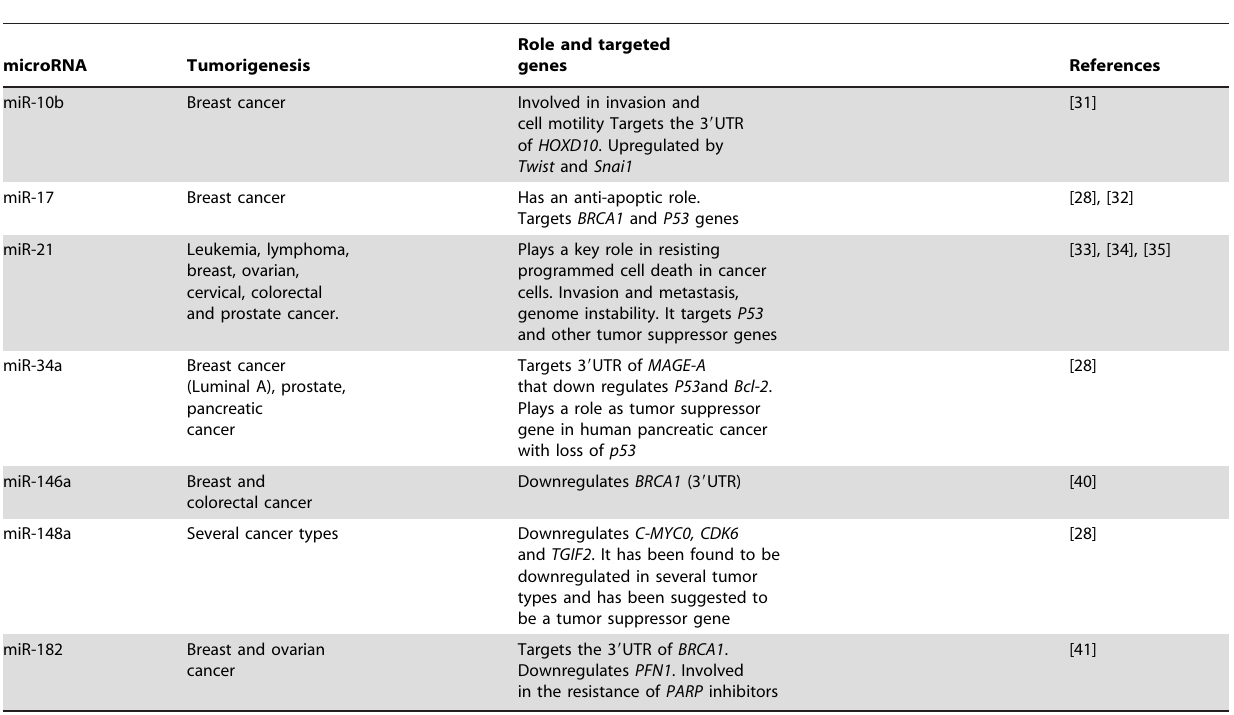
Table 1. Tumorigenesis and targeted genes of the selected microRNAs in breast cancer and other human malignancies.